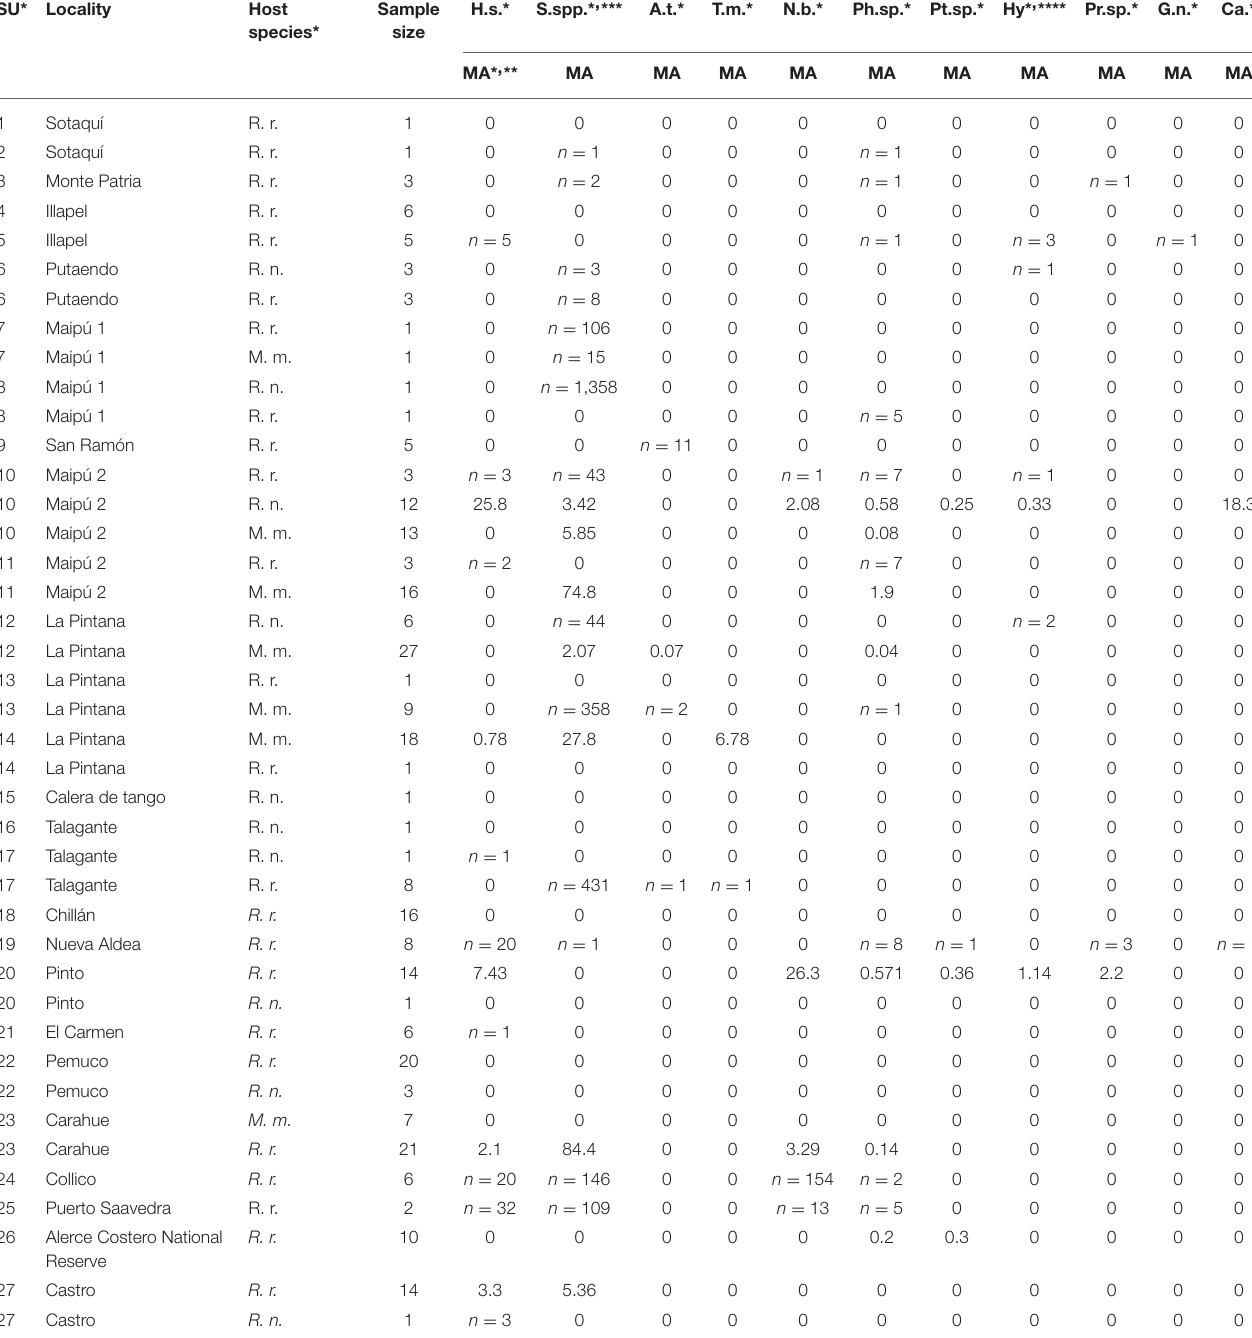
TABLE 1 | Abundances of helminths in allochthonous rodents in Chile by host species and study unit. SU*